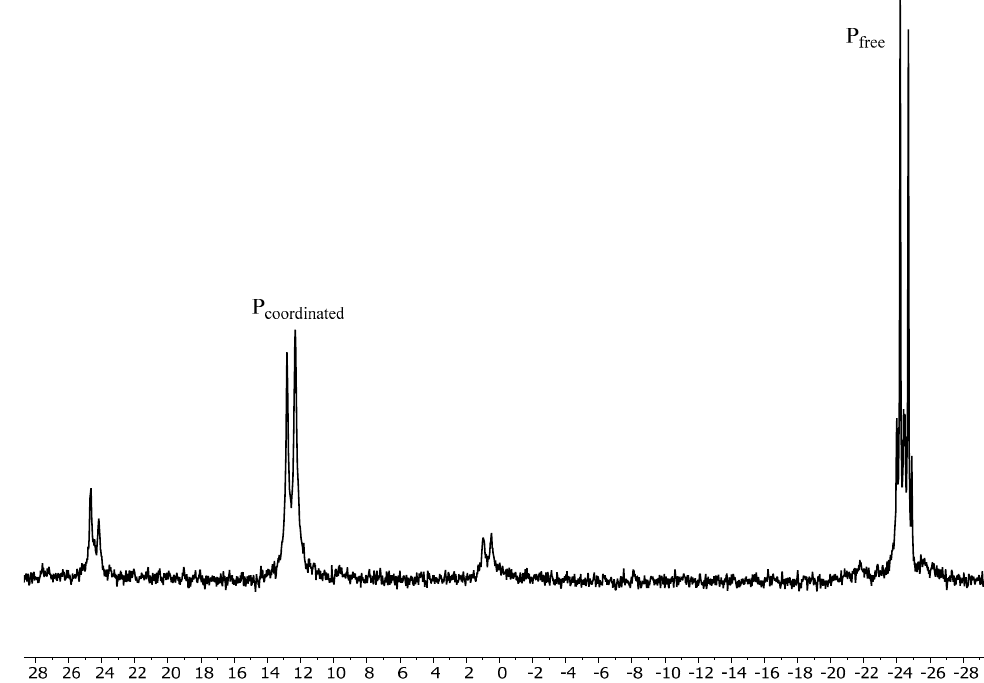
Figure 3. 31 P-{ 1 H} NMR of compound 5c in acetone-d 6